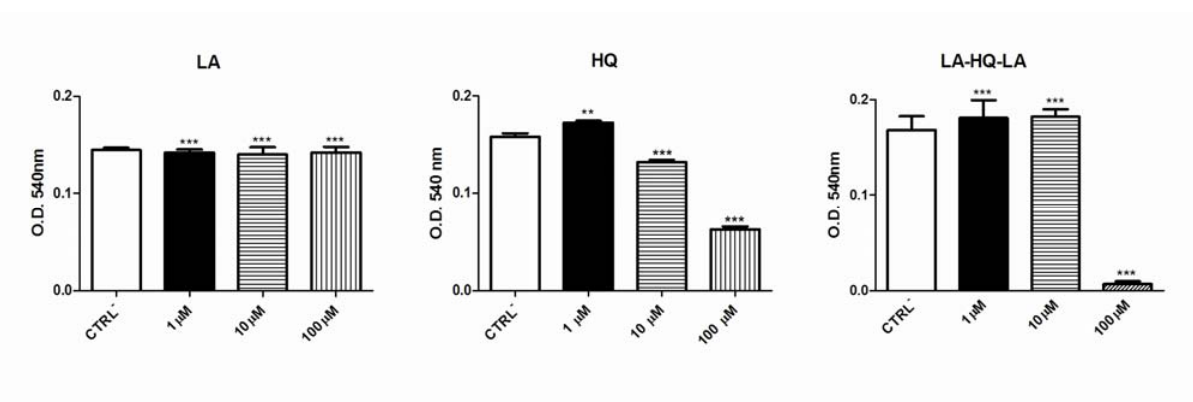
Figure 1. Dose-response effects of LA, HQ, and LA-HQ-LA in undifferentiated SH-SY5Y human neuroblastoma cells a .